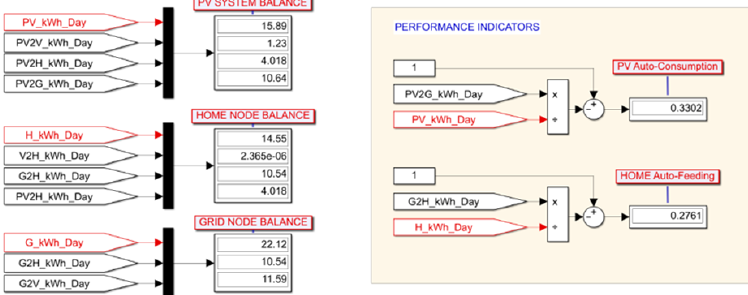
Figure 14. Energy balances at the main nodes ( left ) and performance indicators ( right ) for Case1A— OW 1D.